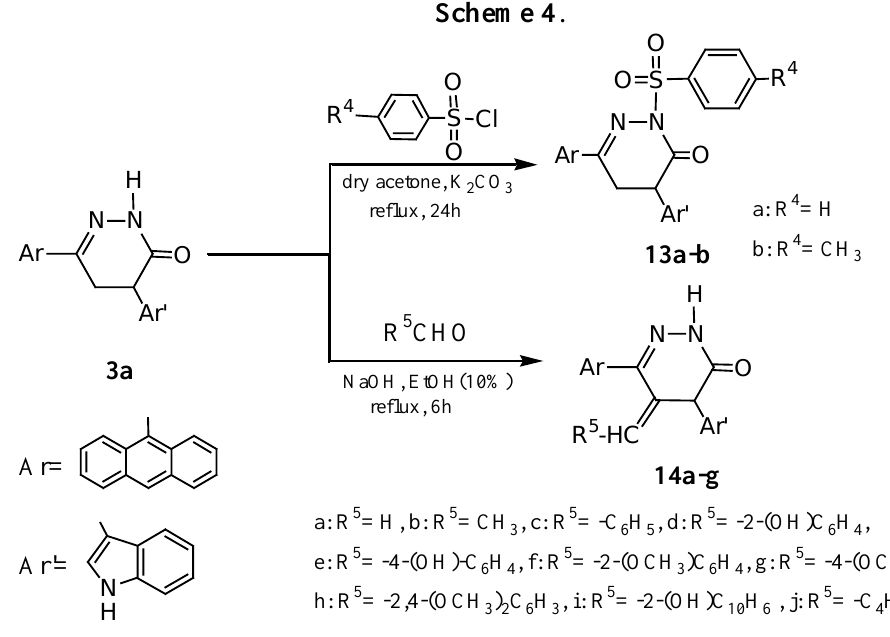
Table 4. Physical properties, mass spectral data and elemental analyses for compounds 13-14 .